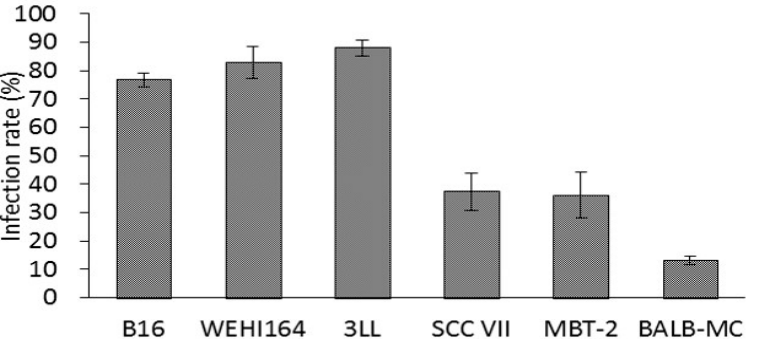
Figure 2. Recombinant NDV (rNDV) infection rate in murine tumor cell lines. Murine tumor cell lines were infected with rNDV (MOI of 2). The infection rate was calculated from the green fluorescent protein (GFP) expressing cell ratio in fluorescent microscopic observation.